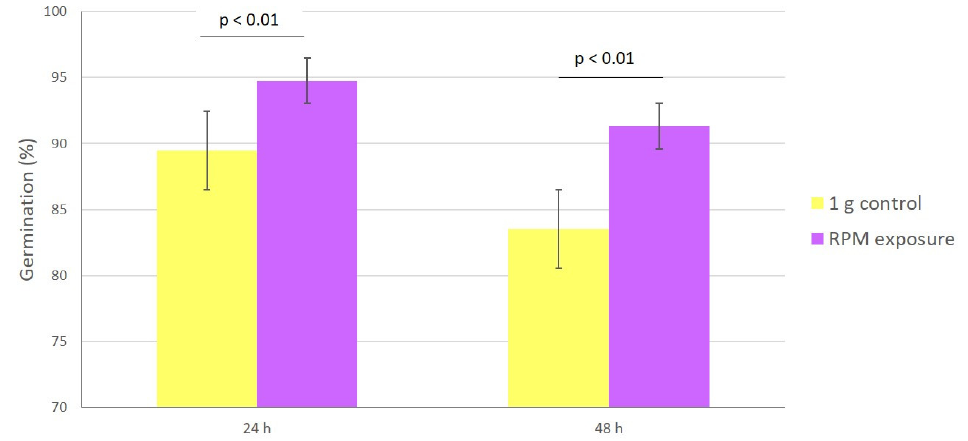
Figure 3. Impact of microgravity on spore germination. Percentage of germination under simulated microgravity (purple) and 1 g control (yellow) conditions at 24 and 48 h of incubation. The experiment was performed twice for all 8 strains subjected to 1 g control or RPM conditions. Data are the mean ± SEM. Statistically significant differences were observed using the Student’s t test.